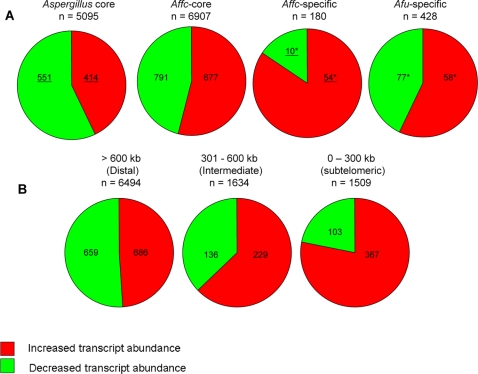
Distribution of lineage specific and telomere-proximal genes among
differentially expressed host adaptation dataset.(A) Lineage specificity of A. fumigatus genes having
altered transcript abundances, relative to laboratory culture, in the
murine lung. The Aspergillus-core (Asp-core) set
contains A. fumigatus Af293 proteins that have
orthologues in A. clavatus (AAKD00000000), N.
fischeri (AAKE00000000), Aspergillus
terreus NIH2624 (AAJN01000000), Aspergillus
oryzae RIB40[70], A. nidulans FGSC
A4[71] and Aspergillus
niger CBS 513.55[72] The Affc-core set were defined as
A. fumigatus Af293 proteins
that have ortholouges in N. fischeri and A.
clavatus. The Affc-unique set is a sub-set of Affc-core
proteins that do not have ortholouges in A. terreus,
A. oryzae, A. nidulans or
A. niger. Asterisks indicate gene sets which are
listed in Table S5. Underlined values
significantly deviate from the null hypothesis that an equal number of
induced and repressed genes will occur in each cohort, as estimated by
Chi-square analysis (Table 3). (B) Chromosomal distribution of A.
fumigatus genes having altered transcript abundances,
relative to laboratory culture, in the murine lung. Distances from
telomeres (kb) are noted above pie charts. Asterisked gene sets are
listed in Supplementary Table S5. Underlined values
significantly deviate from the null hypothesis that an equal number of
induced and repressed genes will occur in each cohort, as estimated by
Chi-square analysis (Table 3).